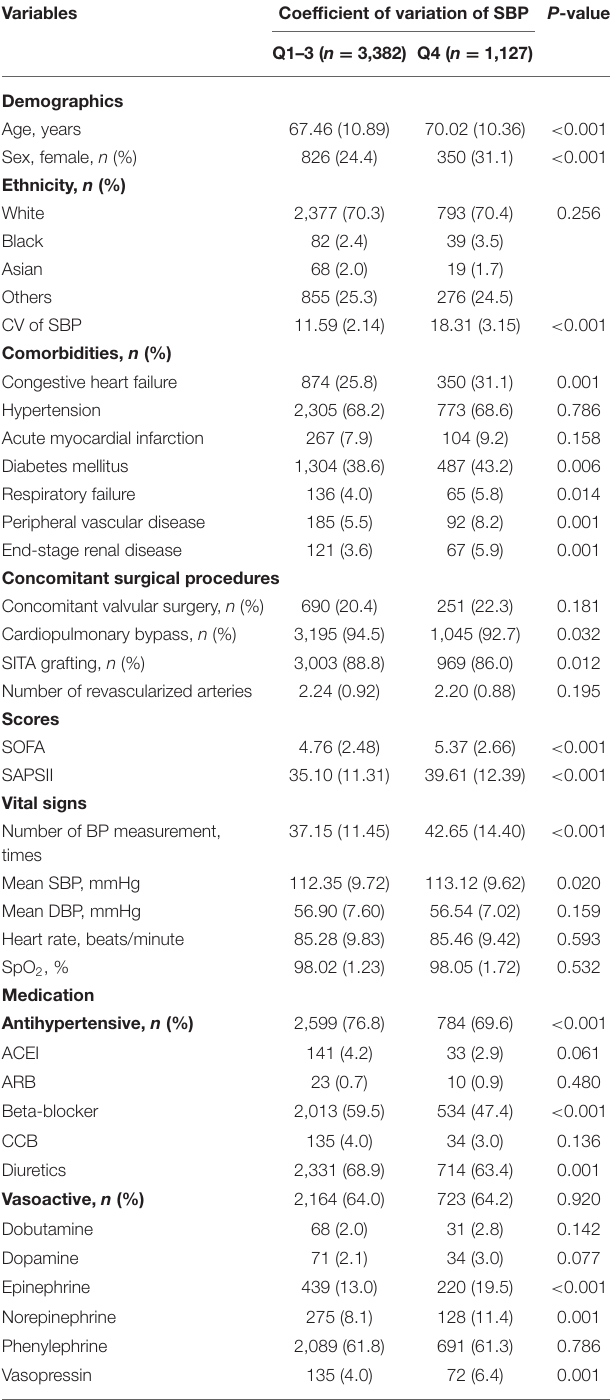
TABLE 1 | Baseline characteristics of patients undergoing CABG, categorized by the coefficient of variation quartiles of post-operative SBP.